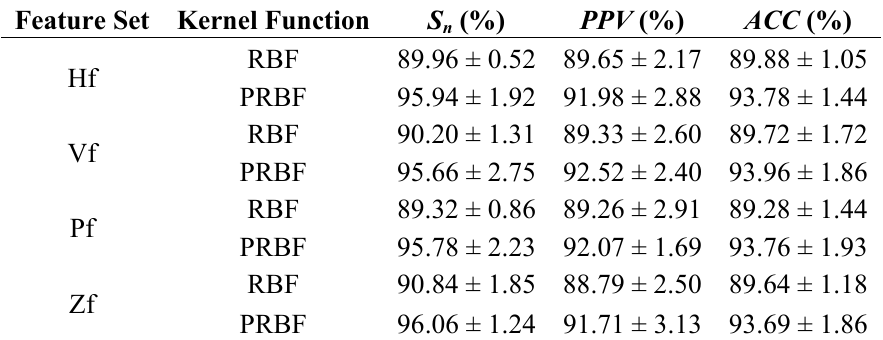
Table 2. Results of RBF and PRBF with DFPCA in the 10 CV test.